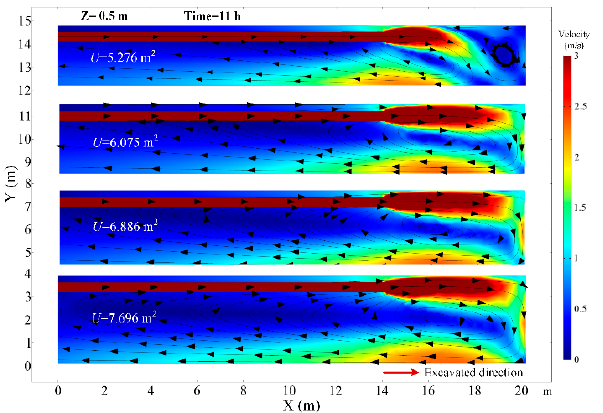
Figure 16. Airflow velocity distribution in Z = 1.0 m plane under different roadway section size.